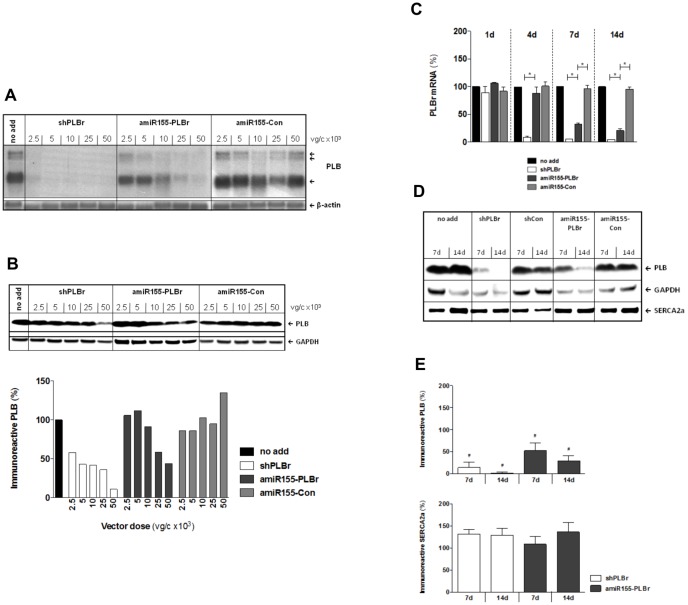
Silencing of PLB in CM by amiR155-PLBr and shPLBr at the mRNA and protein level.(A) Dose dependence of RNAi-mediated PLB mRNA silencing detected by Northern blot analysis. CM were transduced with either scAAV6-amiR155-PLBr (amiR155-PLBr), scAAV6-shPLBr (shPLBr) or control AAV vector (amiR155-Con) and the cells were harvested 7 days later. The multiple bands represent alternatively spliced PLB mRNA transcripts of different lengths. (B) Dose dependence of RNAi-mediated PLB silencing at the protein level for transduction conditions described under A. Upper panel: Representative Western blots showing the immunoreactive signals of PLB and GAPDH. Lower panel: Results of the semi-quantitative analysis of the blots. The obtained PLB/GAPDH signal ratio values were normalized to that of non-transduced cells (no add). (C-E) Time dependence of RNAi-mediated PLB silencing. CM were transduced with 25×103 vg/c of scAAV6-shPLBr, scAAV6-amiR155-PLBr, scAAV6-shCon, or scAAV6-amiR155-Con as indicated and then analyzed at indicated time points. (C) The PLB mRNA expression levels were determined by qRT-PCR. Quantification of relative PLB mRNA levels was done as described under (Figure 2B). (D) Representative Western blot of PLB, SERCA2a and GAPDH. (E) Results of the semi-quantitative Western blotting analysis of four independent experiments. The bars indicate the percentage of PLB (upper panel) and SERCA2a (lower panel) abundance found in scAAV6-shPLBr (shPLBr) and scAAV6-amiR155-PLBr (amiR155-PLBr) vector transduced cells as compared to respective control vector transduced CM exhibiting PLB and SERCA2a abundance of 100%, respectively. *p<0.05 shPLBr vs. amiR155-PLBr and amiR155-PLBr vs amiR155-Con; #p<0.05 vs. cells transduced with the respective control vector scAAV6-amiR155-Con or scAAV6-shCon.